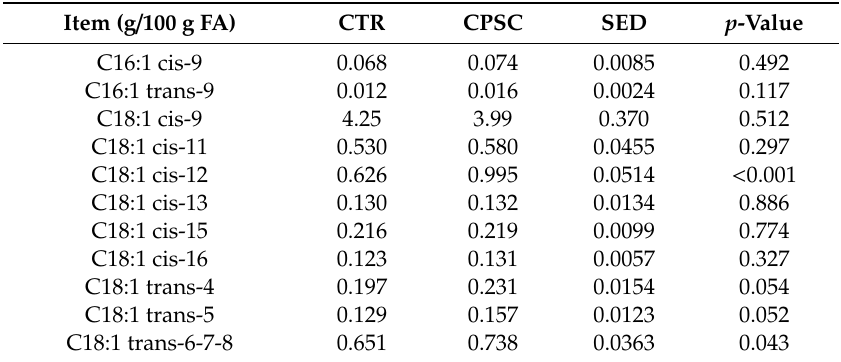
Table 3. E ff ect of feeding cold-pressed sunflower cake on ruminal unsaturated fatty acid composition in dairy cows (n = 10). Item (g / 100 g FA) CTR CPSC SED p